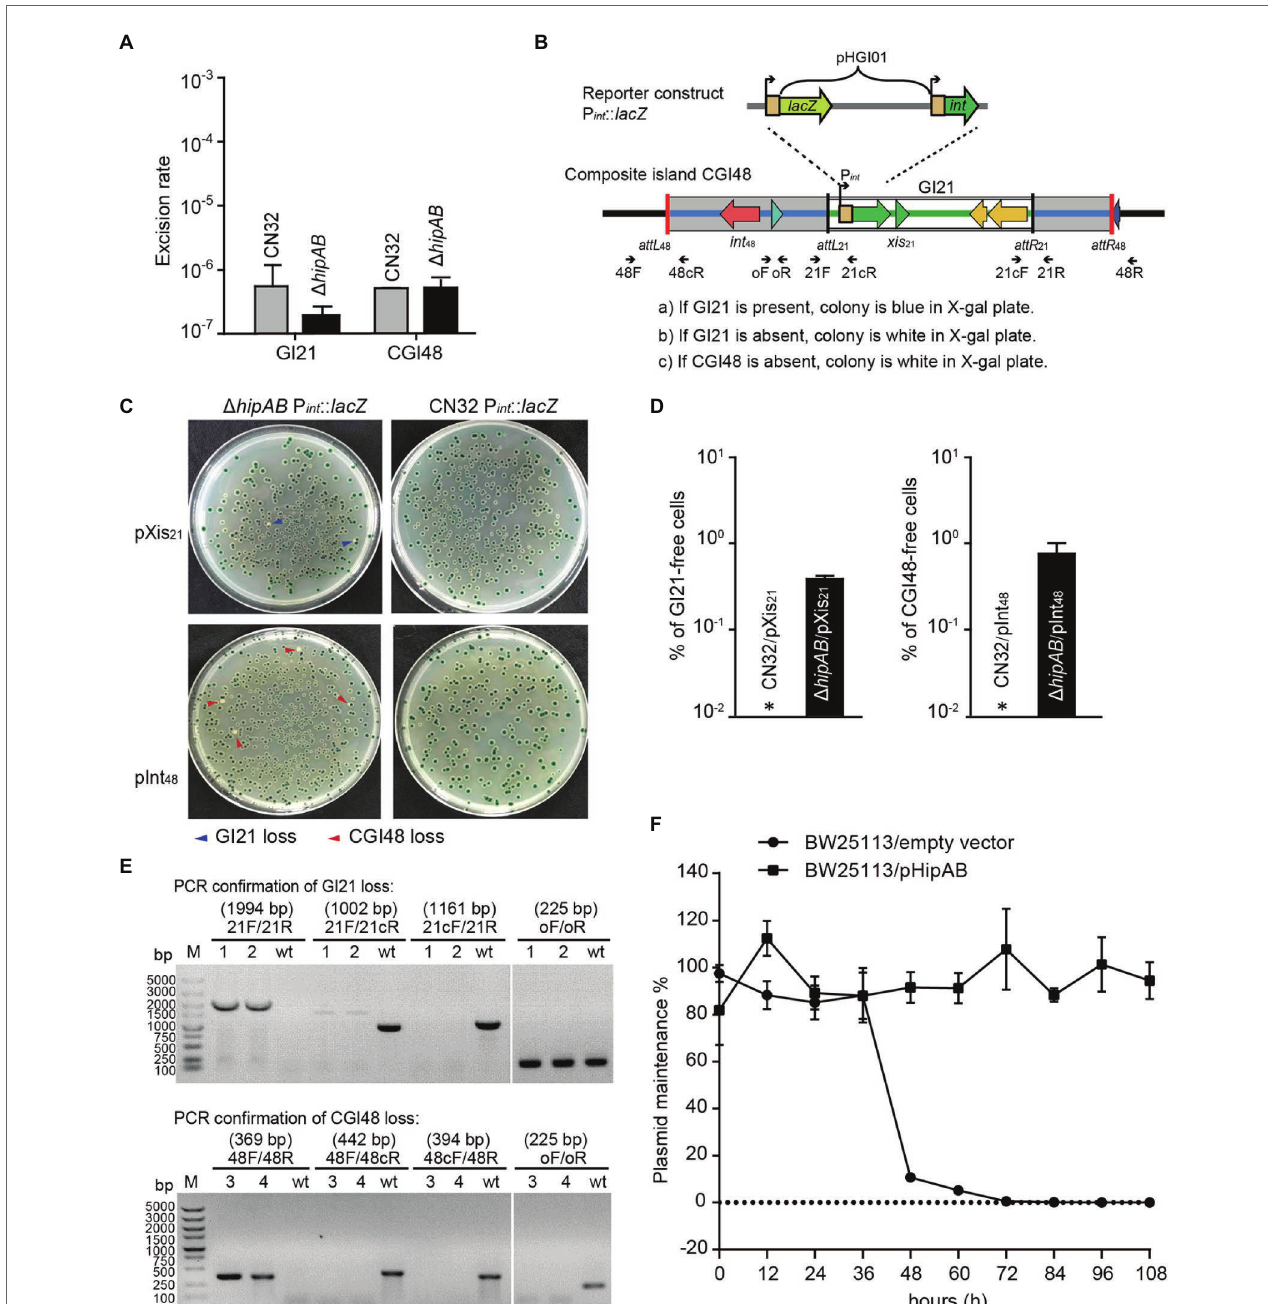
FIGURE 5 | GI21-encoded HipAB promotes the maintenance of CGI48. (A) The excision rate of GI21 and CGI48 in the CN32 wild-type and Δ hipAB mutant strains. (B) Schematic of the lacZ reporter constructs in the CN32 wild-type and Δ hipAB strains. (C) Observation of GI21 loss when Xis 21 is overexpressed (upper plates) and of CGI48 loss when Int 48 is overexpressed (lower plates) on X-gal plates using the lacZ reporter system. (D) % of GI21-free cells (left panel) and % CGI48-free cells (right panel) were quantified by counting five plates, a representative image as shown in (C) . Asterisks indicate that the frequency of GI21 and CGI48 loss was below the limit of detection of the assays (<1 × 10 − 5 ). (E) Confirmation of GI21 (upper panel) and CGI48 (lower panel) loss by PCR using the indicated primers in (B) . 1 and 2 indicate the DNA templates extracted from the colonies with blue arrows in (C) ; 3 and 4 indicate the DNA templates extracted from the colonies with red arrows in (C) ; wt indicates the DNA templates from wild-type CN32 used as a control. Lane M indicates DNA Marker DL5k. The expected product sizes are indicated at the top of the primer sets. (F) GI21-encoded HipAB confers plasmid stability in E. coli . E. coli BW25113 harboring plasmids pHipAB and empty vector pCA24N were used in this assay. Three independent cultures were conducted, and the data are shown as means ±